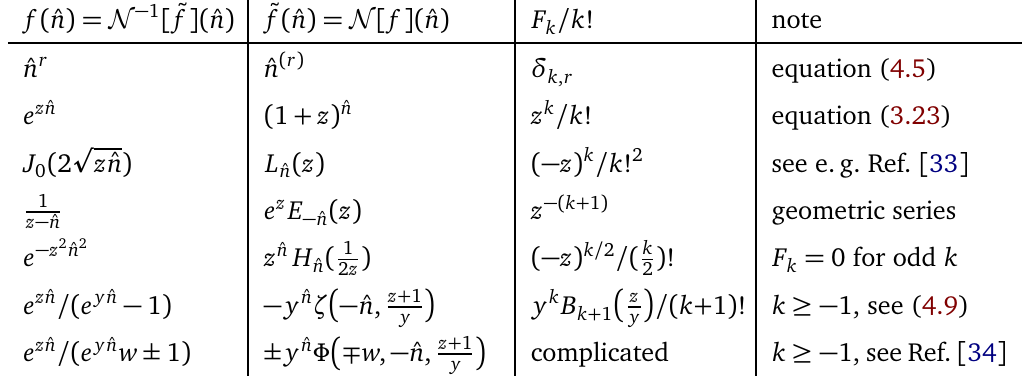
Table 1: Normal-order transform ˜ f ( ˆ n ) of selected functions f ( ˆ n ) , together with